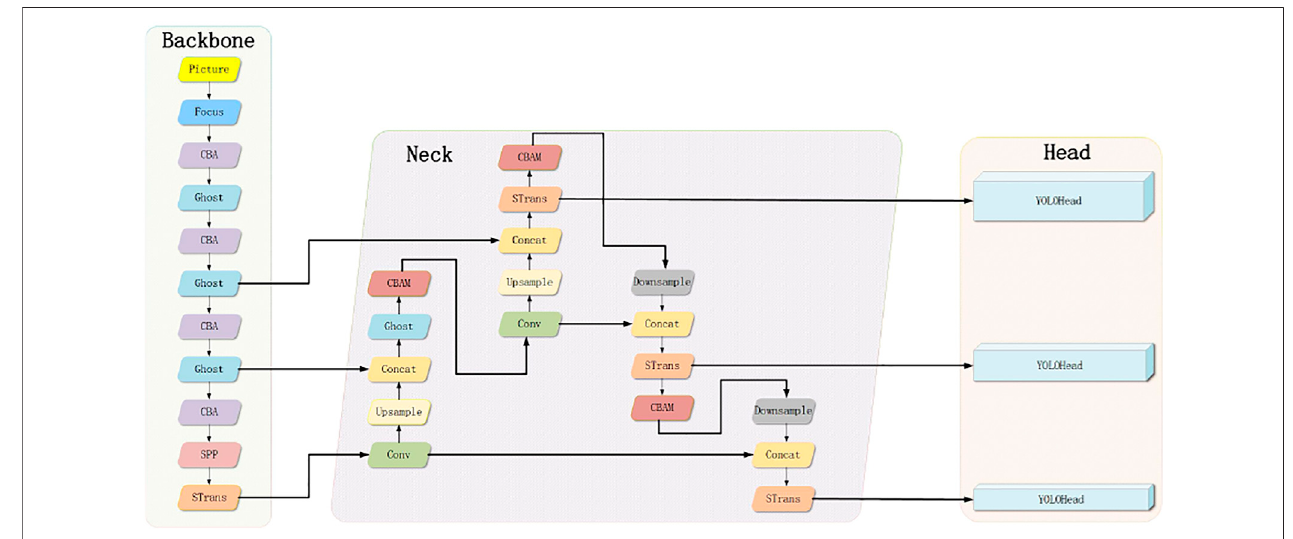
FIGURE 1 | Architecture of the improved YOLOv4 model.